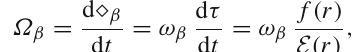
torial plane lead to chaotic dynamics, see the second row in Fig. 6. The locally measured angular frequencies ω r , ω θ , ω φ and ω L are connected to the angular frequencies measured by the static distant observers, Ω β , by the gravitational redshift transformation